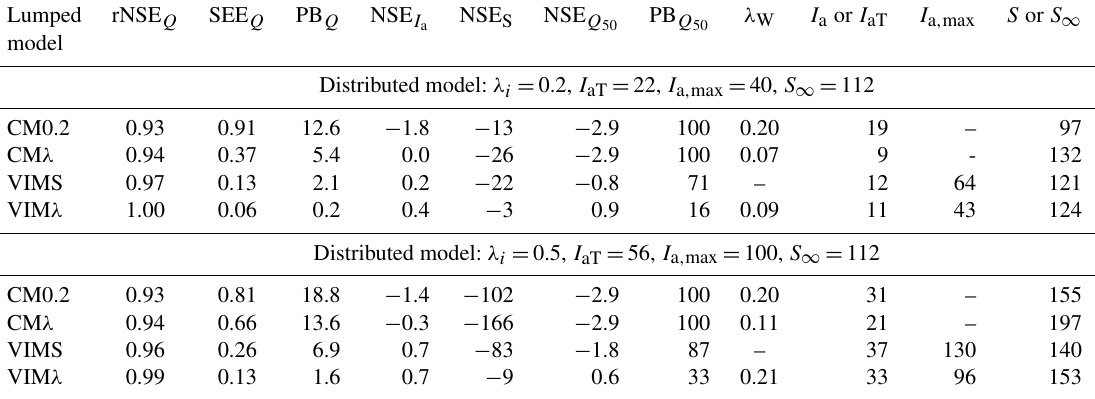
Table 3. The performance of lumped-parameter CN models that were calibrated to the runoff data generated using a distributed CN model for two cases of a synthetic watershed with the storage distribution shown in Table 2. SEE, I a , and S are in mm. (SEE: standard error of estimate, PB: percent bias, NSE: Nash–Sutcliffe efficiency parameter, rNSE: relative